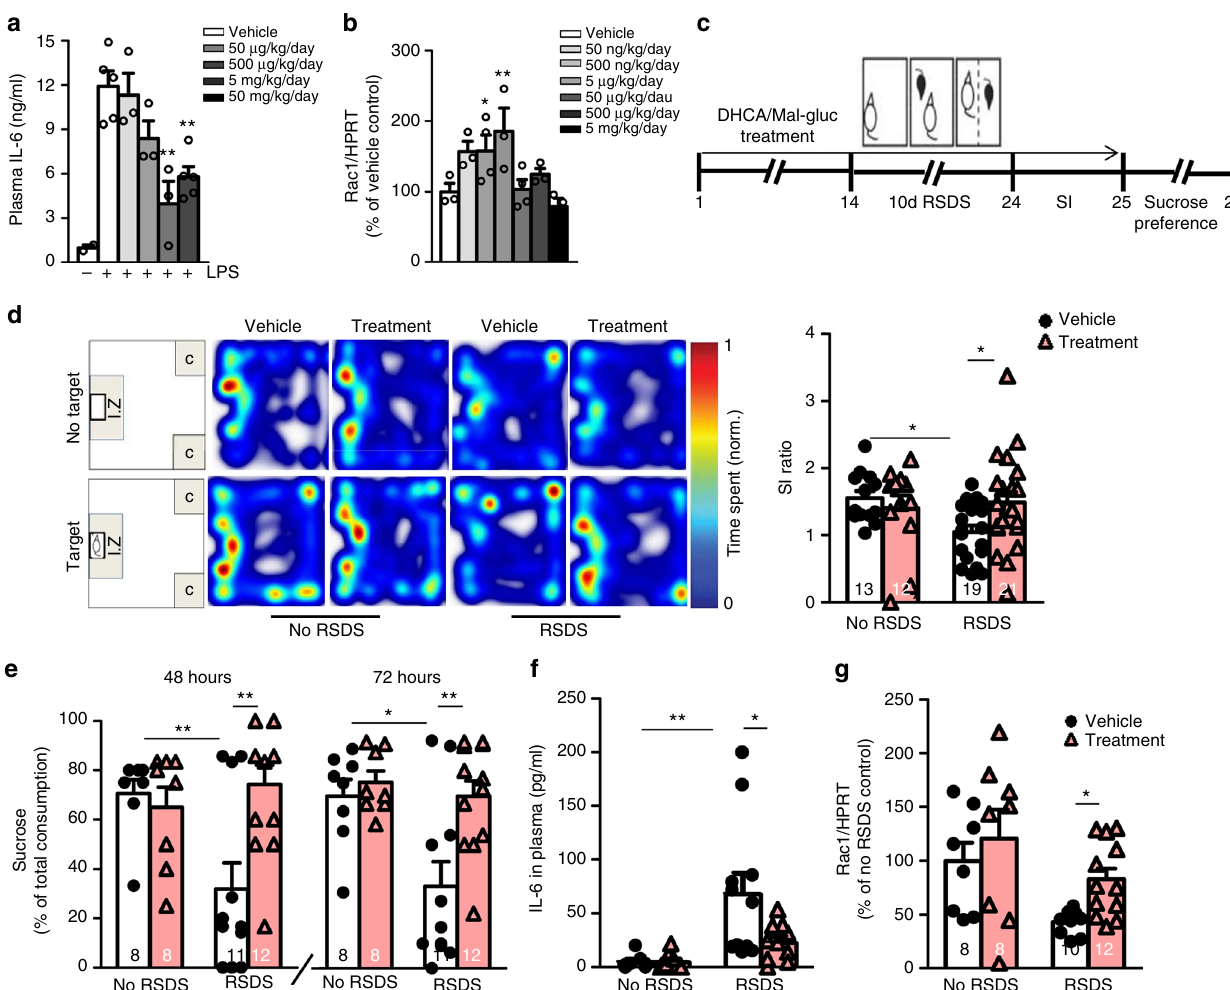
Fig. 3 In vivo dose- fi nding and prophylactic effect of DHCA/Mal-gluc in promoting resilience to RSDS. a IL-6 levels in plasma 6 h post LPS challenge in mice treated with various doses of DHCA for 2 weeks (one-way ANOVA, F 5,20 = 12.50, P < 0.0001, n = 3 – 5 animals per group). b Levels of Rac1 mRNA in the NAc from mice treated with various doses of Mal-gluc for 2 weeks (one-way ANOVA, F 6,22 = 4.22, P = 0.01, n = 3 – 4 animals per group). c Schematic design of the experiment. d Representative heatmaps and scatter plots of social avoidance behavioral test in mice treated with vehicle or DHCA/Mal-gluc for 2 weeks with or without RSDS (one-way ANOVA, F 3,64 = 2.79, P = 0.048). e Sucrose preference test performed 48 h and 72 h following the SI testing (one-way ANOVA, F 3,38 = 5.53, P = 0.003 for 48 h and F 3,38 = 6.73, P = 0.001 for 72 h). f Plasma levels of IL-6 24 h following the last defeat (one-way ANOVA, F 3,35 = 6.25, P = 0.002, n = 7,8,11,10 mice). g Rac1 expression 48 h following the last defeat (one-way ANOVA, F 3,37 = 4.81, P = 0.007). All graphs represent mean ± s.e.m., * P < 0.05, ** P